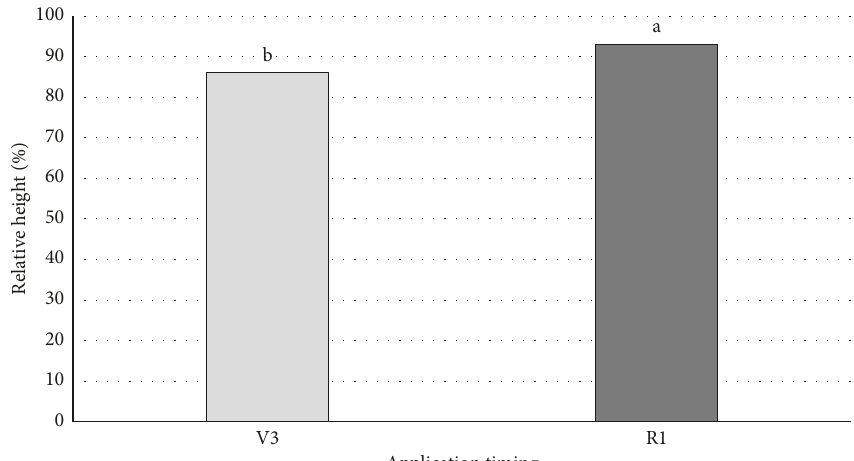
Figure 4: Soybean heights collected at maturity and made relative to the nontreated check according to the main effect of application timing for the cultivar experiment conducted in Fayetteville, AR, in 2019. Treatments not sharing any lowercase letter are significantly different according to multiple comparison analysis α � 0.05